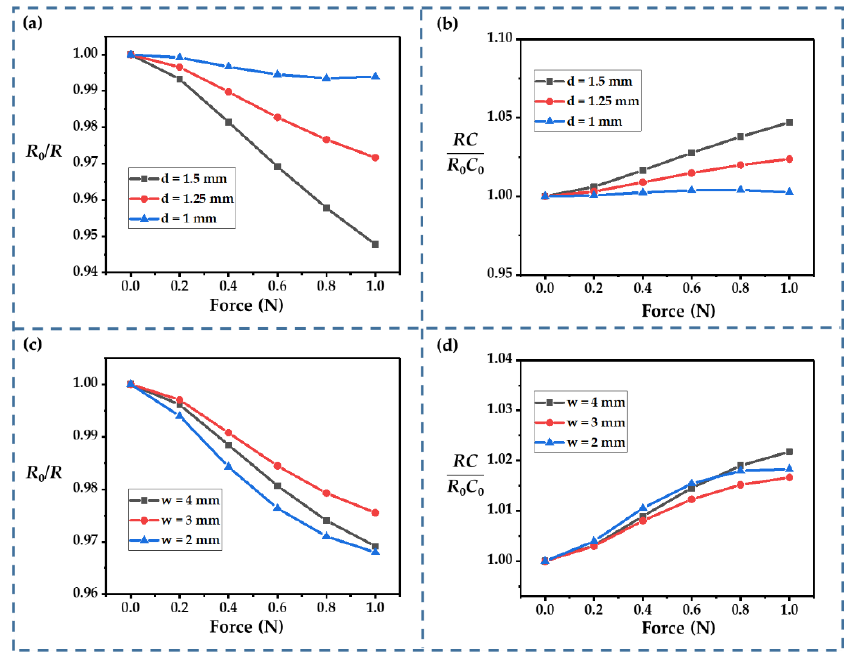
Figure 8. ( a , b ) Influence of d on R 0 / R and RC / R 0 C 0 . ( c , d ) Influence of w on R 0 / R and RC / R 0 C 0 .